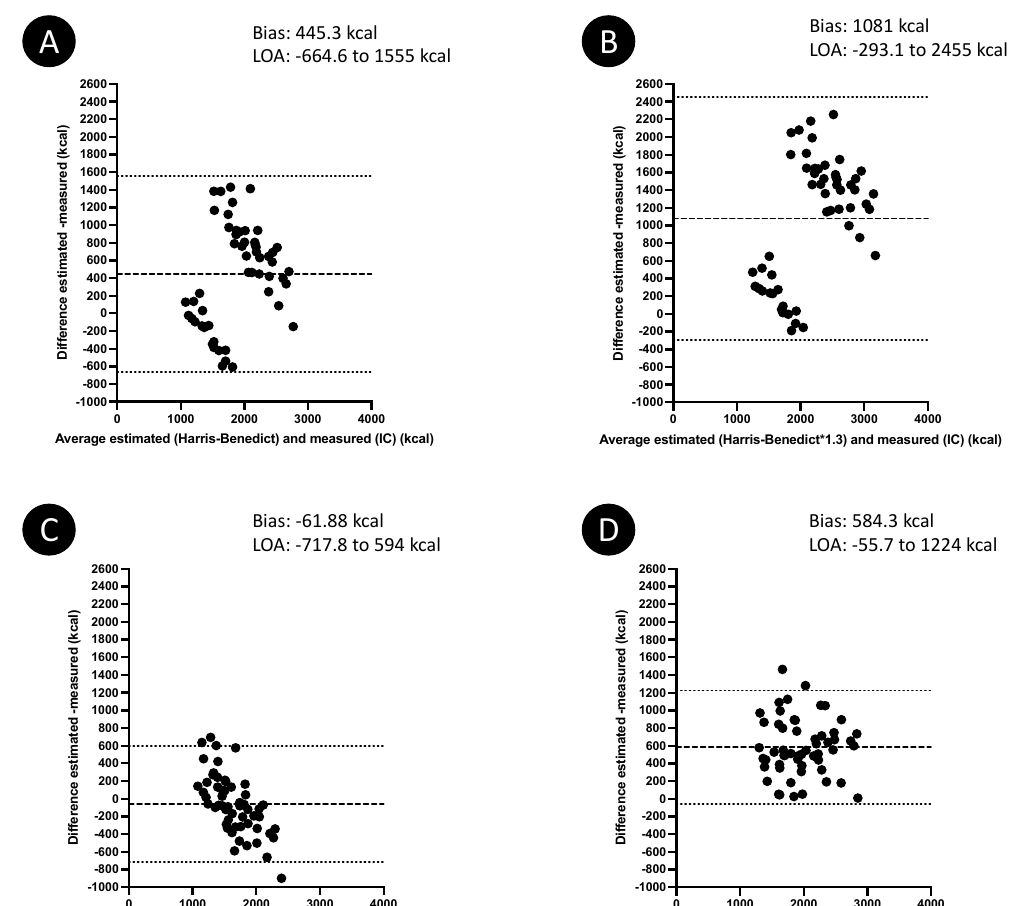
Figure 2. Bland–Altman plots showing the difference between estimated energy expenditure and measured energy expenditure using indirect calorimetry as the comparison method. The estimation was based on the Harris–Benedict equation ( A ), the Harris–Benedict equation corrected with a 1.3 stress factor ( B ), the Penn–State equation ( C ), and the 30 kcal/kg formula ( D ). Mean differences are represented by dashed lines, limits of agreement (LOA) are represented by dotted lines.